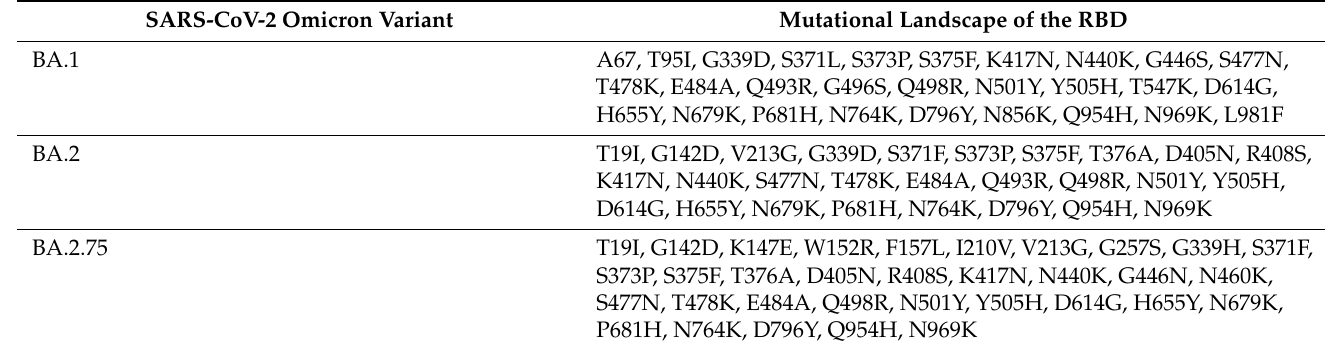
Table 3. Structures of the S Omicron trimers examined in this study.